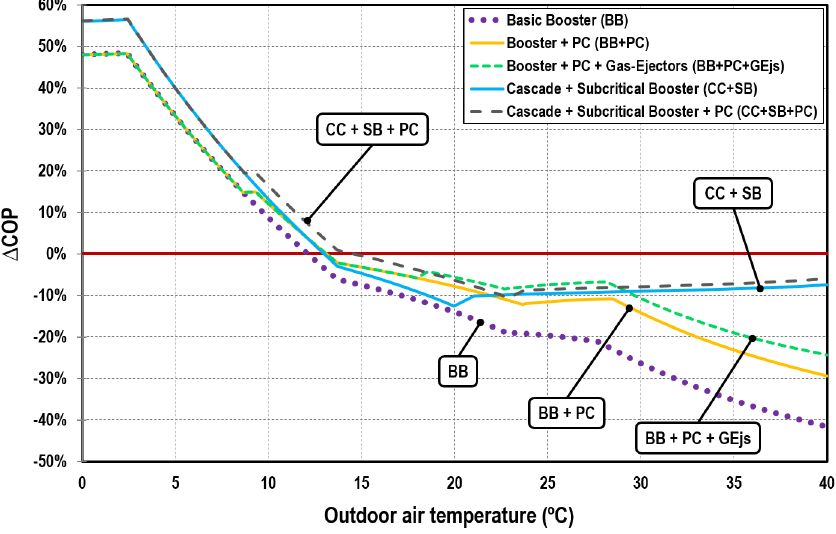
Figure 10. COP increment of each system with respect to R513A/R744 cascade.